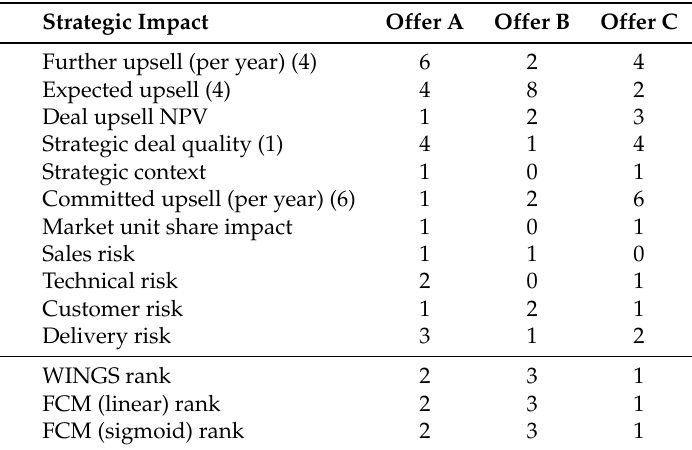
Table 3. Comparison of FCM and WINGS—strategic impact